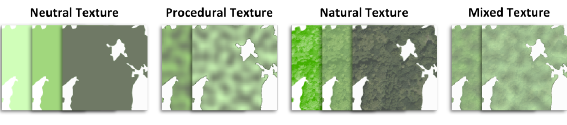
Figure 3: Our texture typology.